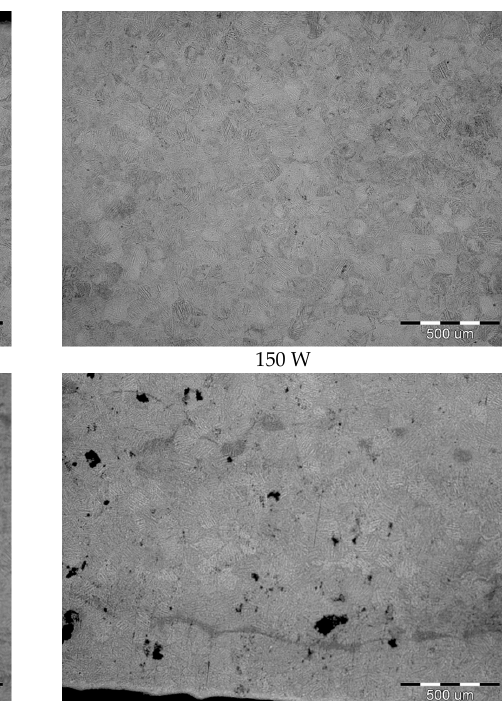
Figure 7. Microstructure of sintered materials, mag. 500×, LM. Microstructure of materials after stress ‐ relief annealing are shown in Figure 8.